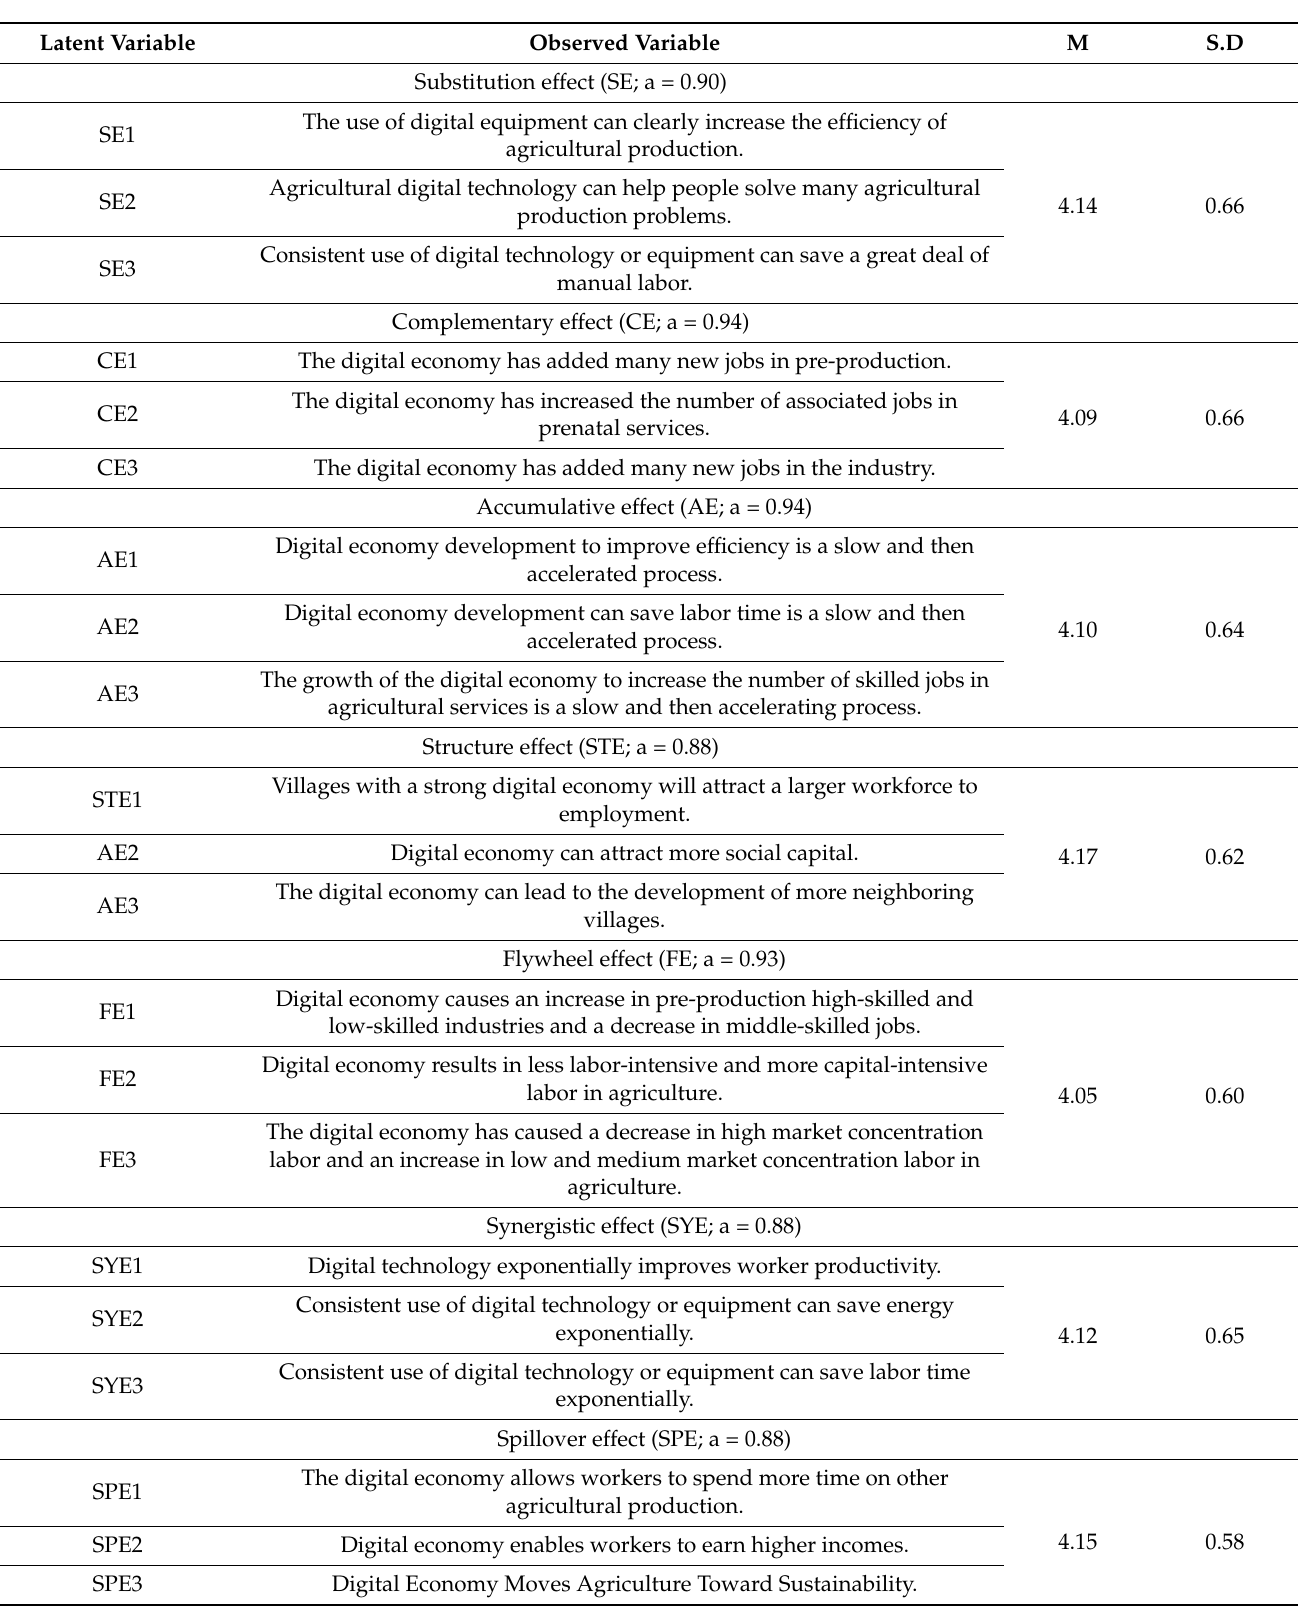
Table 1. Latent variables, observed variables, mean values, and standard